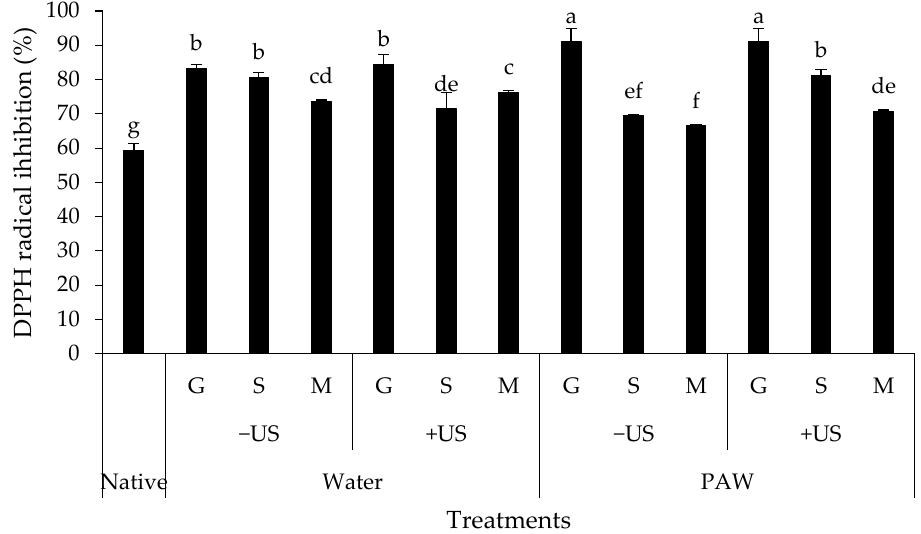
Figure 9. DPPH radical inhibition of rice starch–phenolic complexes. Different phenolic compounds— gallic acid (G), sinapic acid (S), and crude Mon-pu ( Glochidion wallichianum Muell Arg) (M) extract— were complexed with hydrothermally pre-gelatinized rice starch prepared using distilled water (Water) or plasma-activated water (PAW) without ( − US) and with (+US) the aid of ultrasonication. The native starch (Native) was used to compare. Bars represent the standard deviations from triplicate determinations. Different letters on the bars indicate the significant differences ( p <